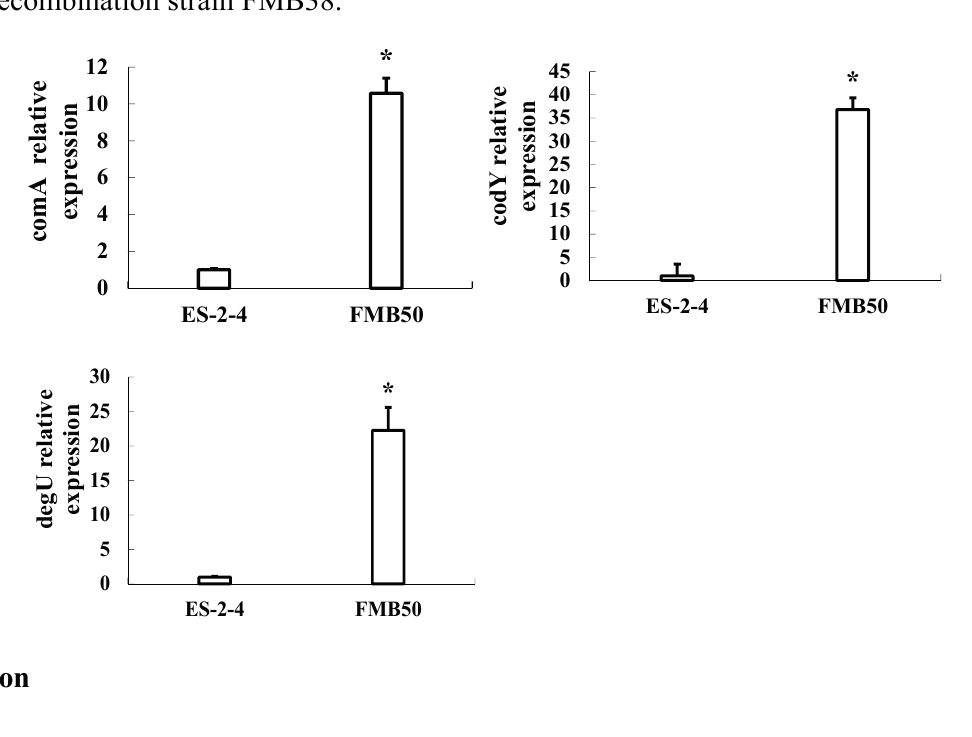
Figure 3. qRT-PCR analysis of mRNA expression of comA , degU and codY genes. Asterisks indicate a statistically significant difference ( p < 0.05) between the parental strain ES-2-4 and recombination strain